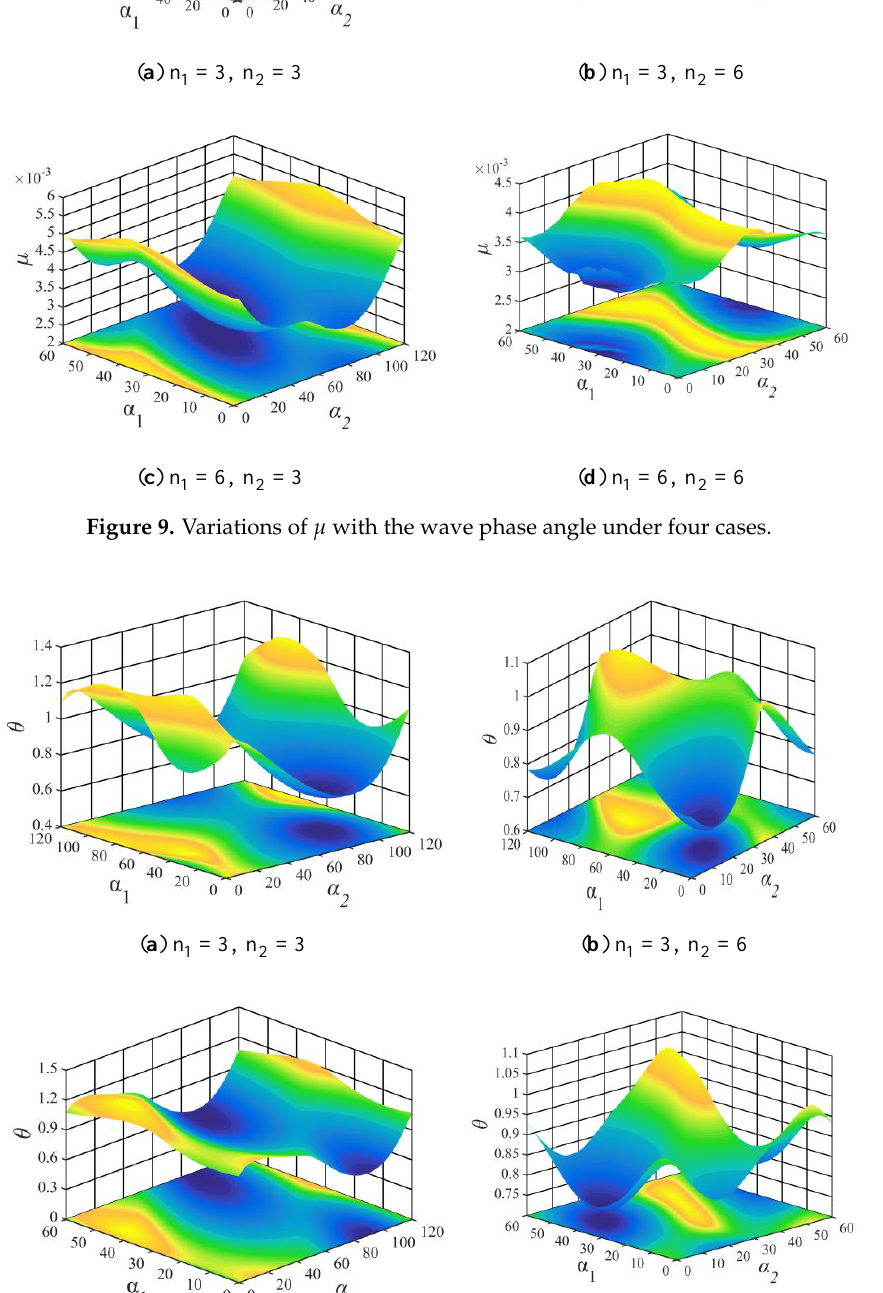
Figure 11. Schematic diagram of the oil pressure without surface waviness. 4.3. Effect of the Waviness Number Figure 12 shows the bearing dimensionless load capacity F , dimensionless end leak- age flow rate Q , circumferential friction coefficient  and altitude angle  against the eccentricity ratio under the same circumferential waviness amplitude ratio and different waviness numbers. It can be seen that with the decrease of the waviness number, the range of change for F , Q ,  and  became more pronounced. This is mainly due to the fact that the curvature radius of the oil film thickness and the pressure near the attitude